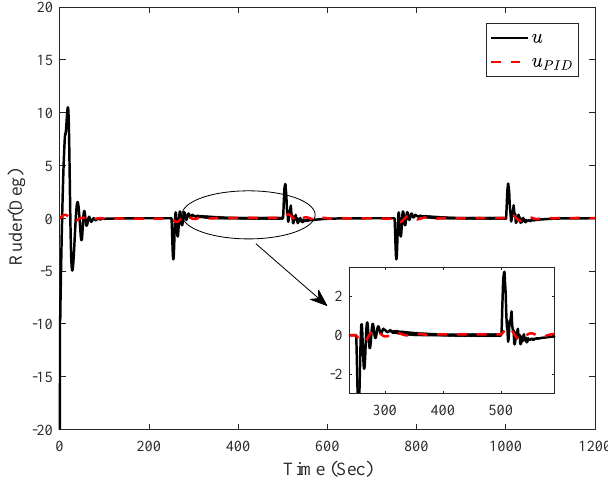
Figure 8. Curves of controllers.